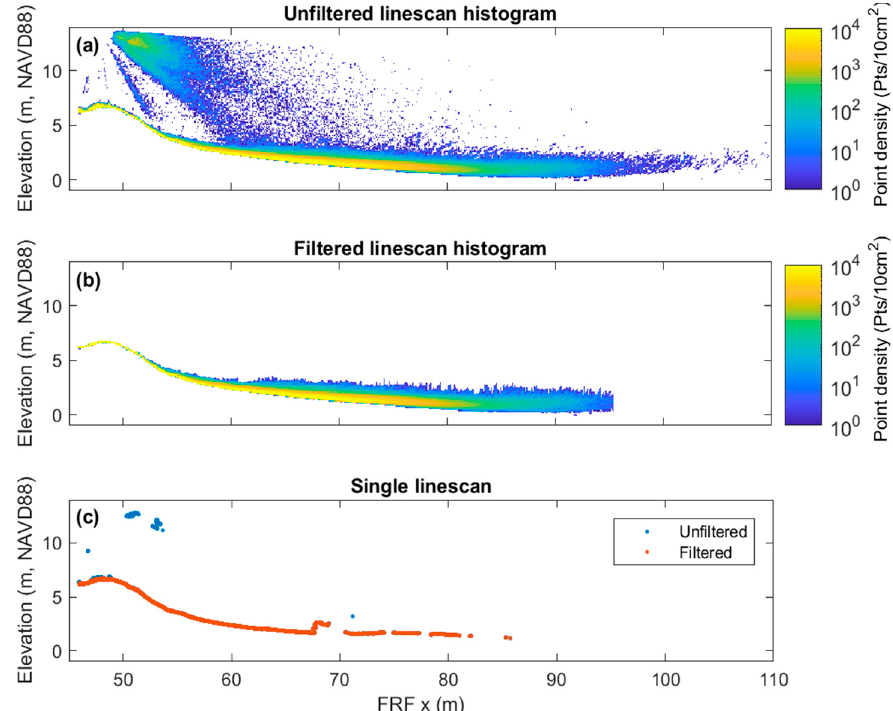
Figure 7. Two-dimensional histograms of point densities from an ( a ) unfiltered and ( b ) filtered 30-min linescan time series, along with ( c ) a singled filtered (red) and unfiltered (blue) linescan example, all from 9 October 2016 07:00 UTC (during Hurricane Matthew).